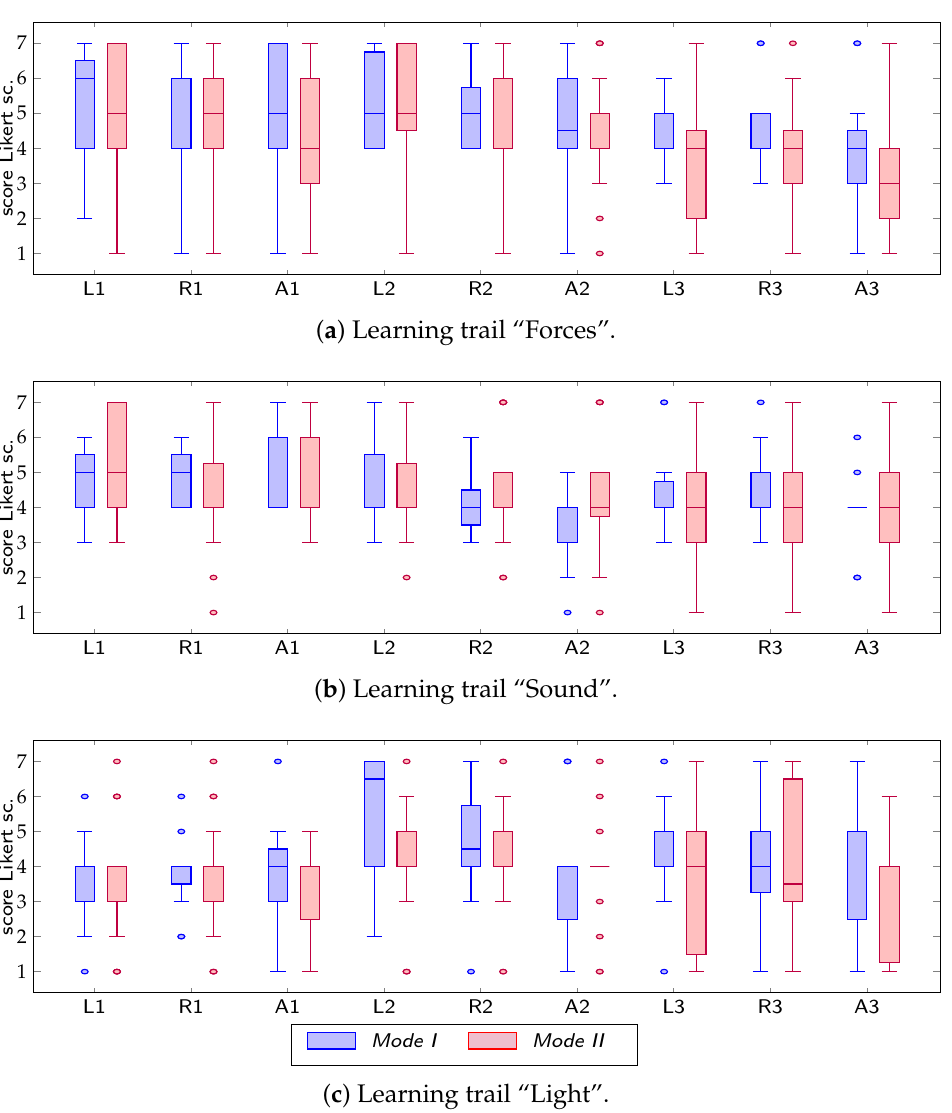
Figure 5. Response scores for tests with three learning trails and the three stations i on a Likert scale for the variables for like L i , recommend R i and play again A i . The number of participants is n = 113 ( 34, 38, 41 ) .